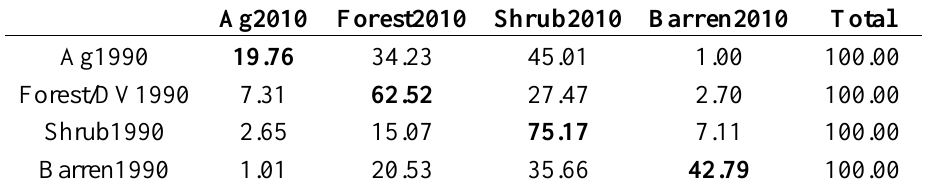
Table 3. Land cover class conversion matrix from 1990 to 2010. Rows indicate the distribution (%) of class